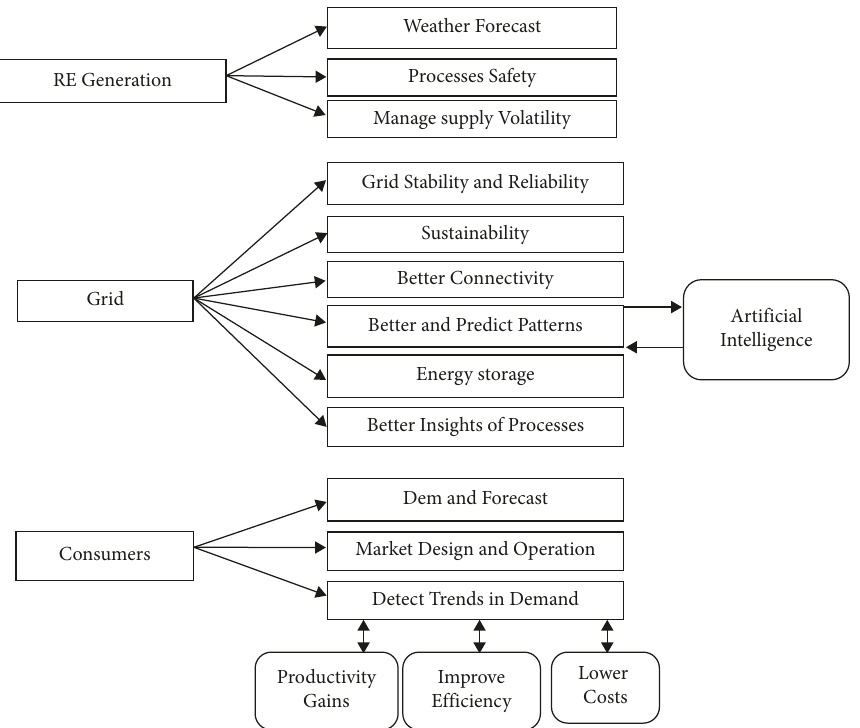
Figure 1: Integration of energy systems with artificial